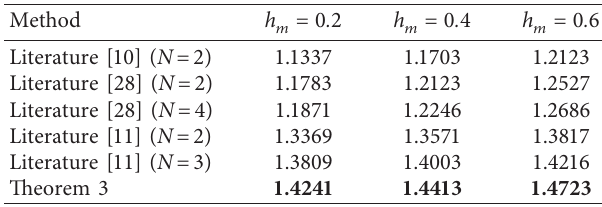
Table 1: In Example 1, MADB is simulated to be obtained for different h m and different methods.